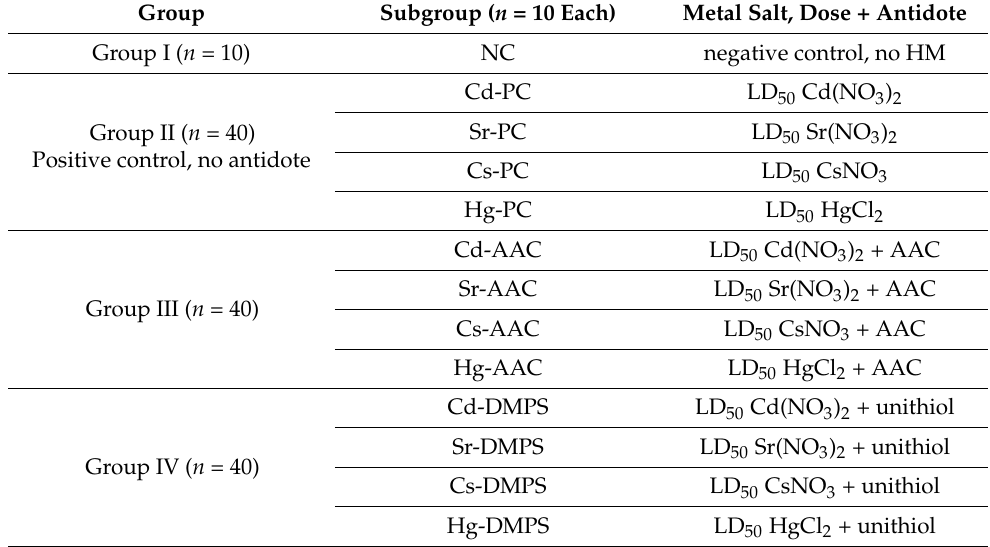
Table 4. Groups of experimental